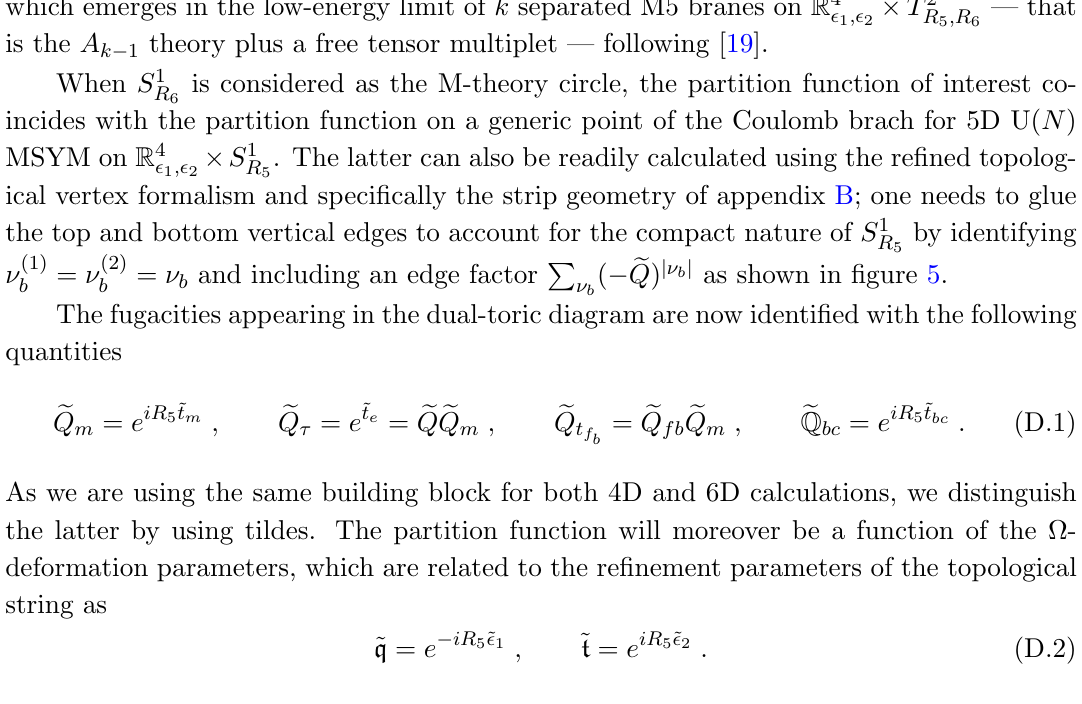
Figure 5 . The dual-toric diagram for the (2 , 0) k theory on R ǫ is along the compactified circle and is highlighted in red, and the wrapping around the circle is indicated by blue, along with its partition ν b and the associated fugacity geometry as in figure 3 but corresponding to a theory with a single node. There are no non-trivial framing